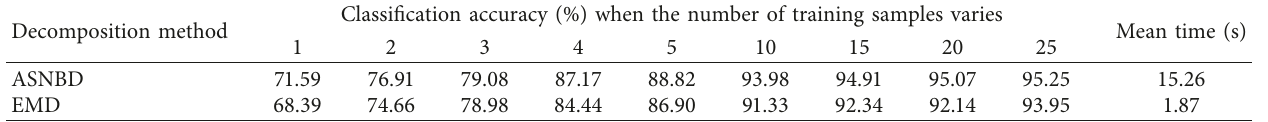
) in experiment 2. 1